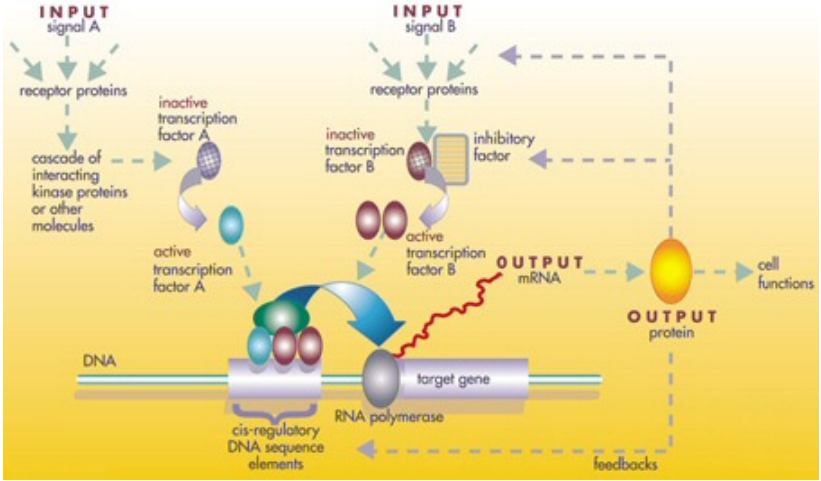
Figure 4. Genetic regulatory network (credit US Department of Energy).